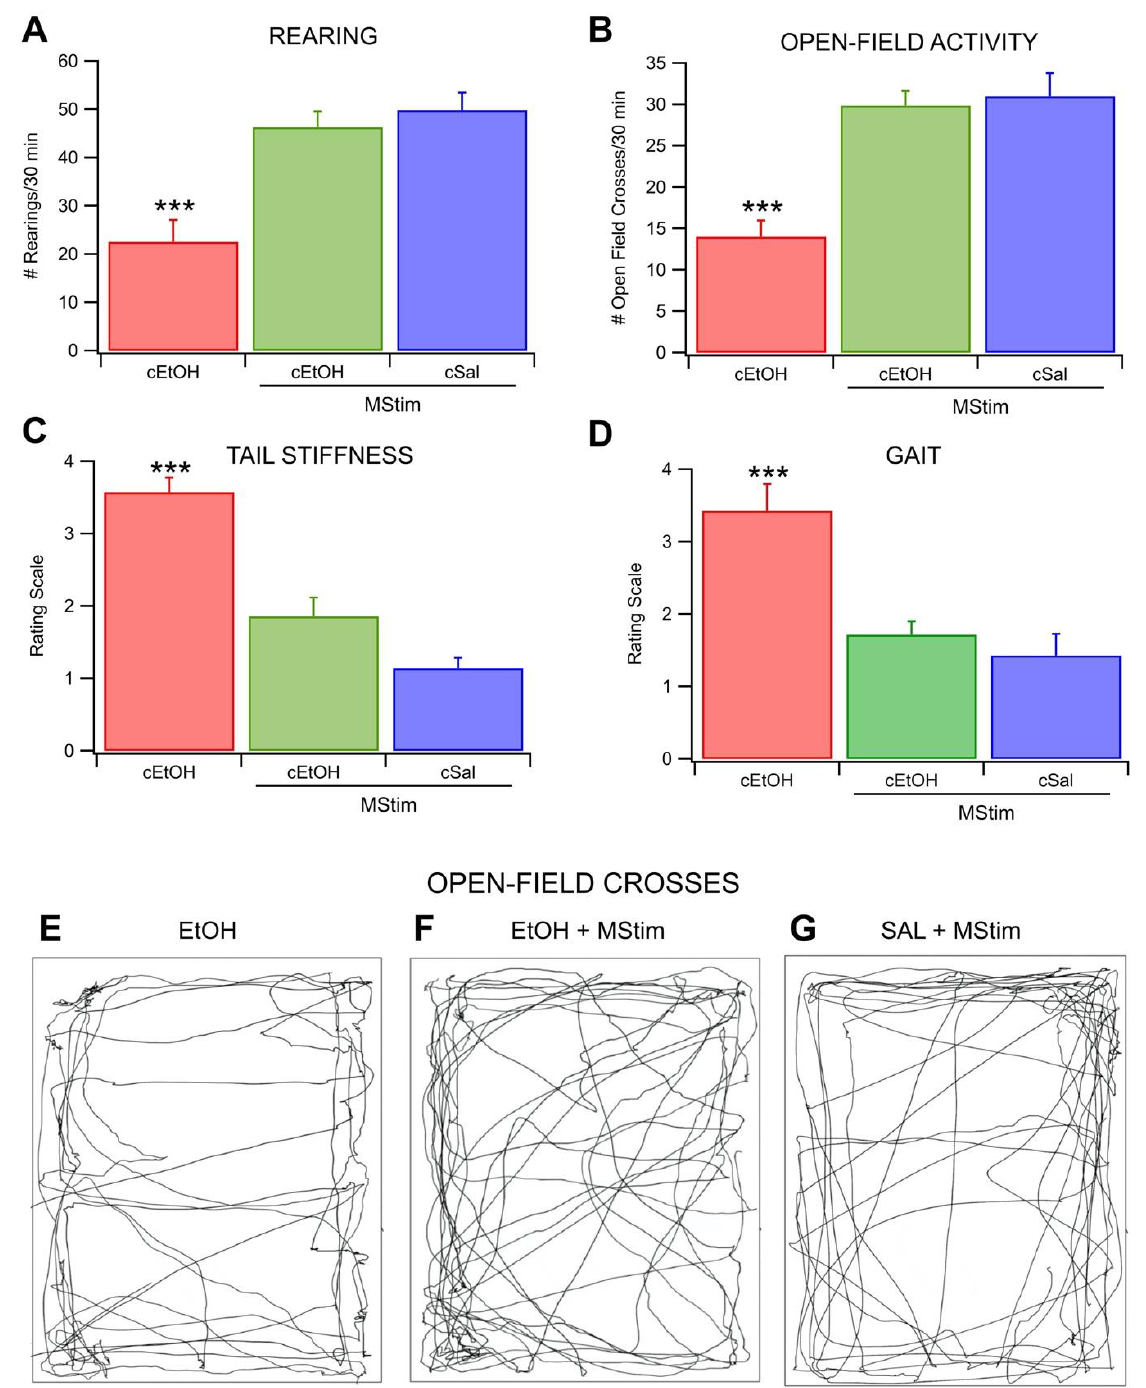
Figure 4. Blocking of EtOH-induced behavioral measures of withdrawal by MStim. ( A ) Number of times the animal reared-up on hind legs in 30 min period. ( B ) Number of times the animal crossed through the middle third of the chamber in a 30 min period. ( C ) Subjective rating of tail-stiffness. ( D ) Subjective measure of the animal’s gait. Note that all measures improved with the concurrent administration of MStim during chronic EtOH exposure. ( E – G ) Representative traces of the animals movement patterns during testing. Asterisks (***) indicate significance level p < 0.001. Time in the open arm of the elevated-plus maze was significantly different between experimental groups ( F (3,20) = 4.6455, p = 0.0127; Figure 5). As expected, chronic ethanol withdrawal (141.41 ± 20.34 s) lowered time in the open arm when compared to air controls